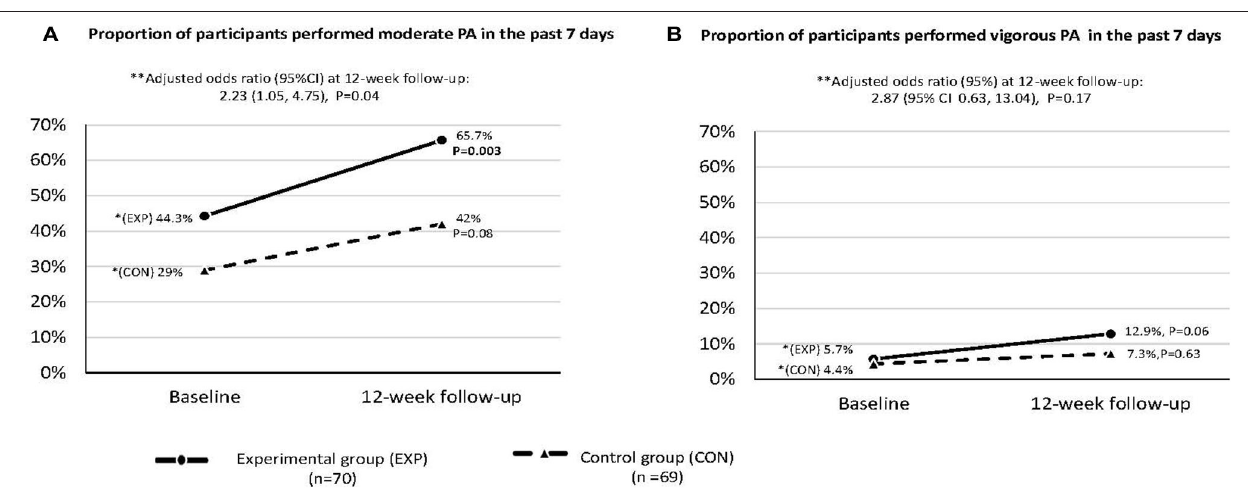
[adjusted mean difference (95% CI): 0.86 ( − 0.66, 2.39, P =